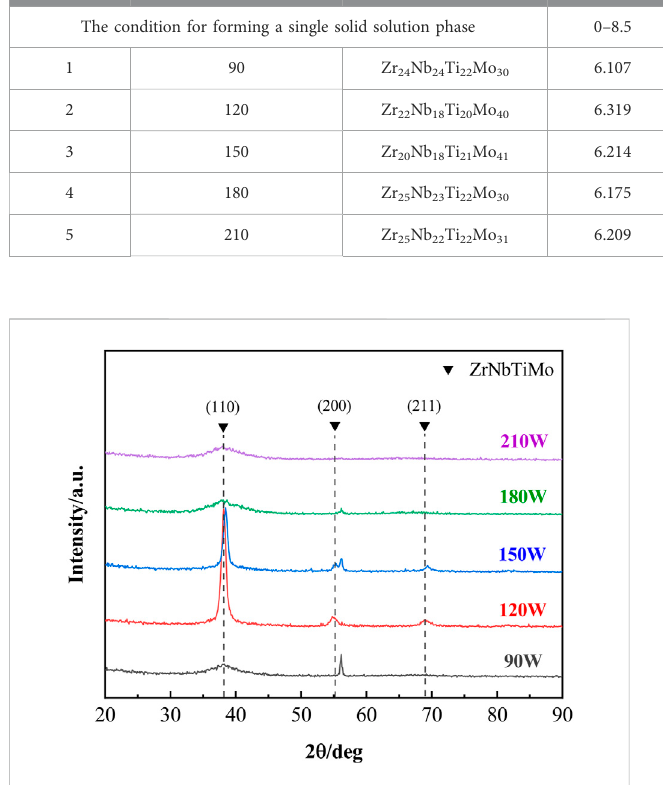
FIGURE 3 XRD patterns for the ZrNbTiMo RHEA fi lms deposited at different sputtering power.